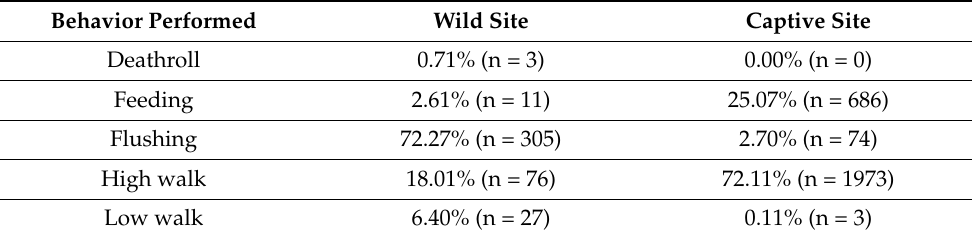
Table 2. The proportion of each general behavior at each site, presented as the percentage of each type of general behavior divided by the total number of general behaviors performed at that site with behavior counts in parentheses (n = 422 for the wild site and n = 2736 for the captive site; data collected 09:00–14:30).